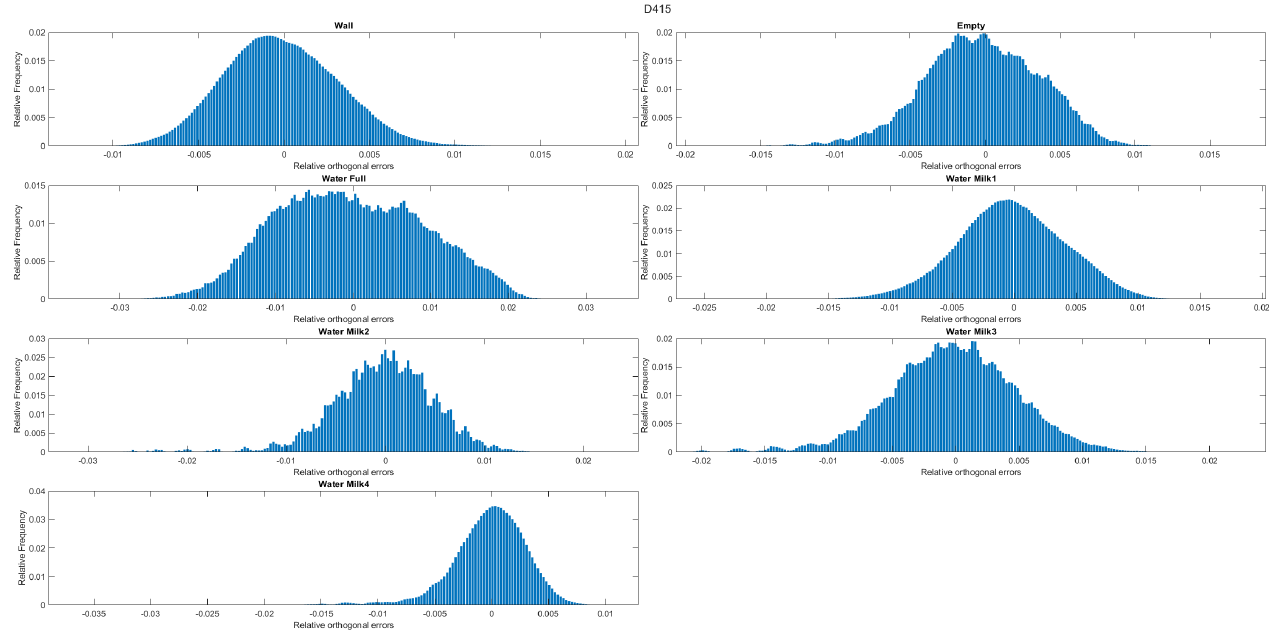
Figure 15. Histogram of orthogonal distances for the D415 camera.